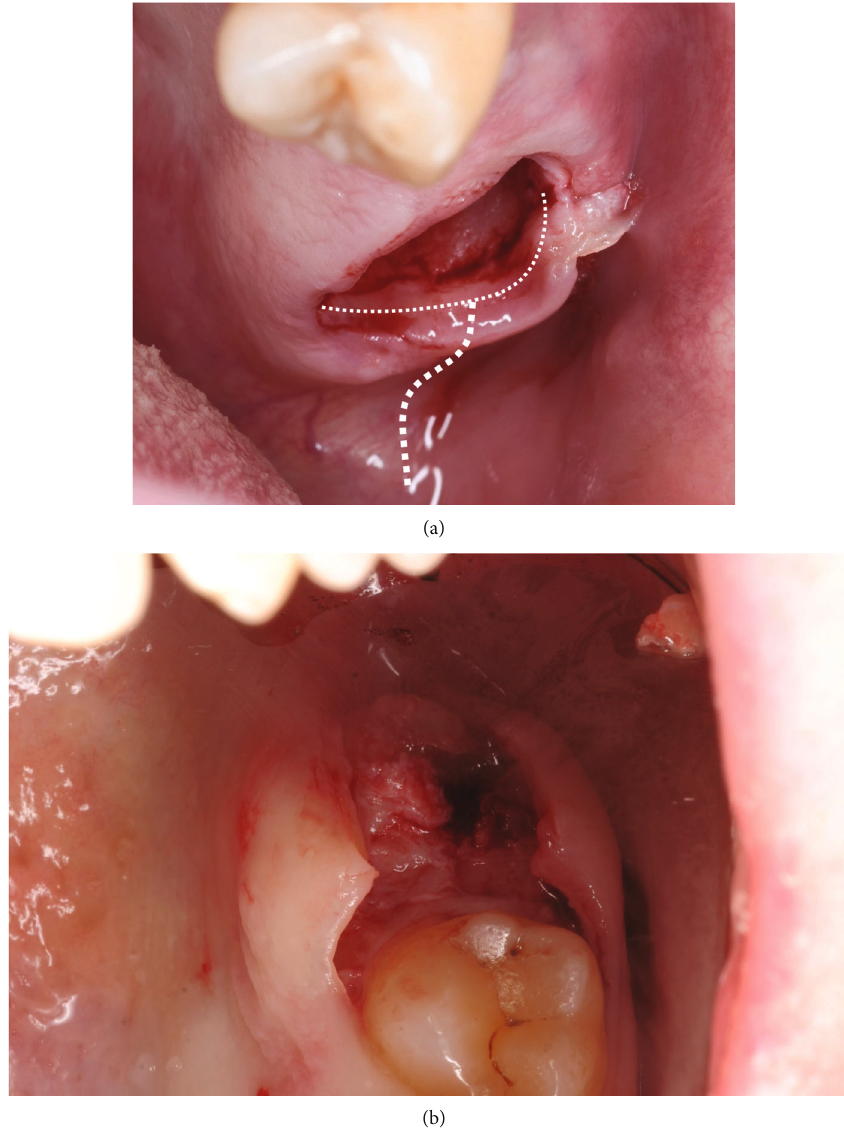
Figure 7: (a) Split-thickness incision to facilitate access for the chisel. (b) Split-thickness incision to facilitate access for the